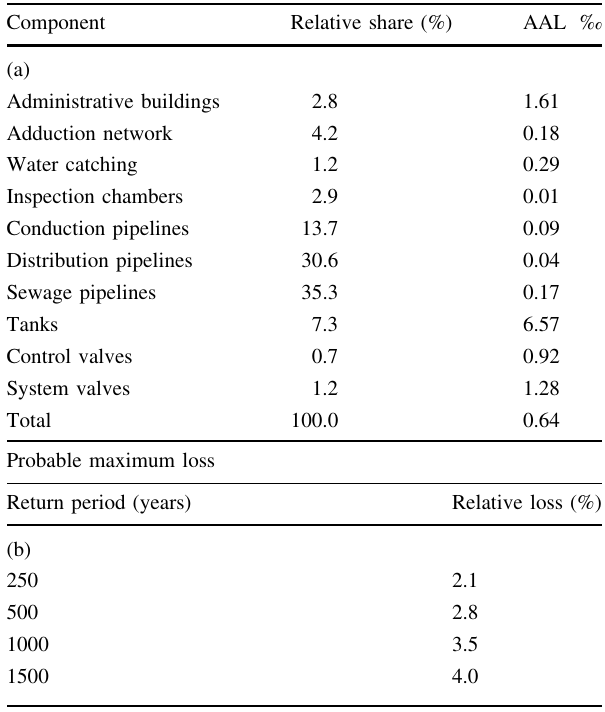
Table 1 Exposed value and average annual loss (AAL) by compo- nent for the Aguas de Manizales network (a), and probable maximum loss (PML) for different return periods of the Aguas de Manizales network (b) in Manizales,